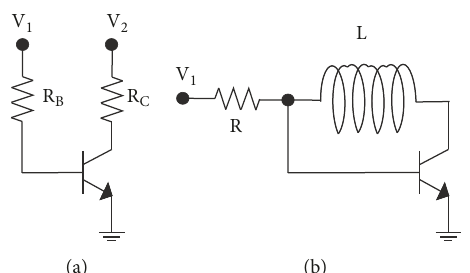
Figure 1: (a) Representation of the active mode in circuits. (b) Proposed circuit for the unusual operation.